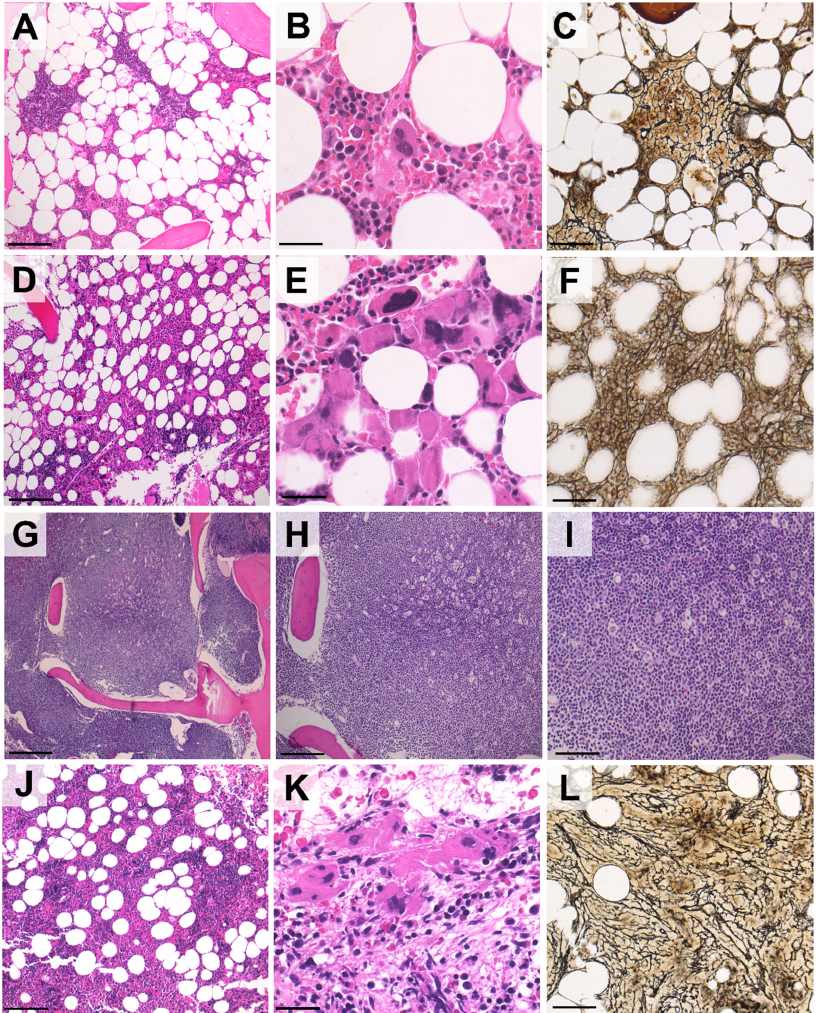
Figure 1. Representative histological features of post-CLL PMF following treatment with ibrutinib or venetoclax. ( A – C ). In patient #1, the BM before ibrutinib therapy was normocellular ( A ) with maturing hematopoietic cells and a nodular infiltrate of small lymphocytes consistent with CLL ( B ). Mild reticulin fibrosis was associated with CLL nodules ( C ). ( D – F ) Six months into ibrutinib therapy, BM cellularity was increased ( D ) and large, tight clusters of atypical megakaryocytes with bulbous nuclei were present ( E ). A reticulin stain disclosed diffuse MF-2 grade fibrosis, prompting the diagnosis of PMF (fibrotic stage) ( F ). ( G – I ). Areas of bone marrow in patient #2 before venetoclax therapy, showing diffuse infiltration by CLL cells. ( J – L ) Nine months after venetoclax was started, the bone marrow of patient #2 also presented tight clusters of megakaryocytes and MF-2 grade